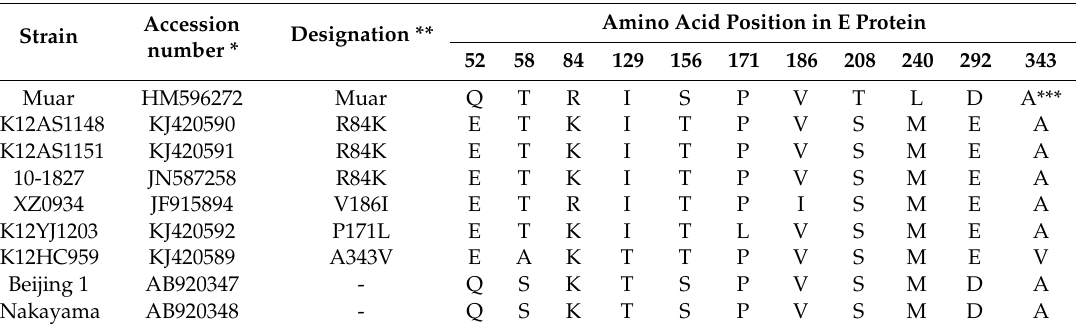
Table 1. Amino acid substitutions among JEV GV Beijing 1